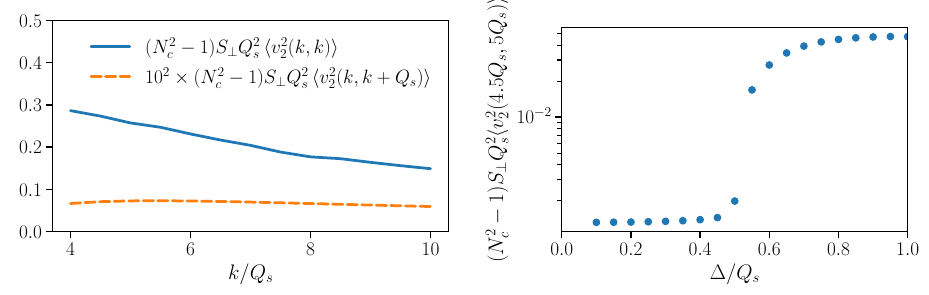
Fig. 1 Left panel: the second flow harmonic, v 2 the saturation momentum of the target in order to avoid the gluon HBT as a function of the 2 effect. The bin width in both cases is (cid:10) = Q s / 2. Right panel: the sec- momentum. The calculation of v 2 is performed for two cases: a the 2 ond flow harmonic, v 2 as a function of the bin width. The centers of the same momentum of the pair, b the momentum of the pair is offset by 2 two bins are chosen at k = 4 . 5 Q s , k (cid:3) = 5 Q s